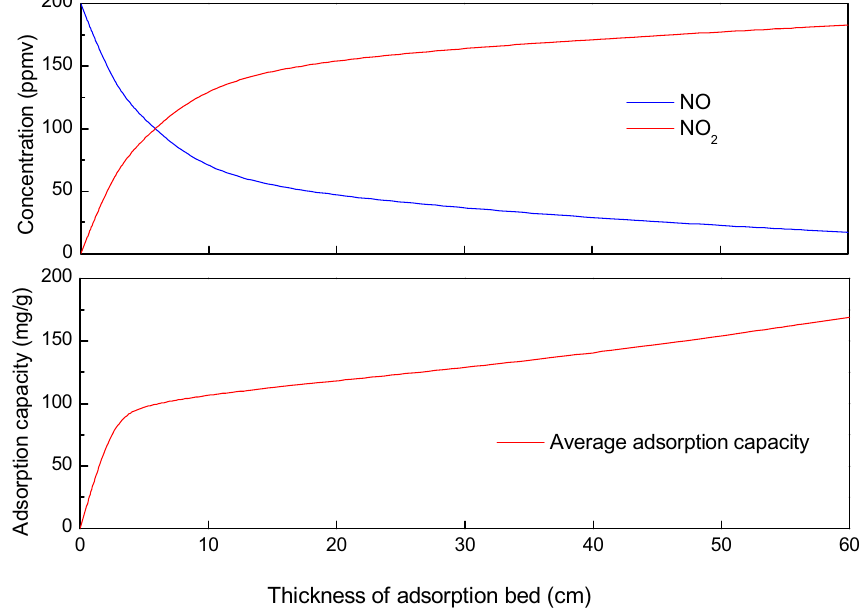
Figure 9. Oxidation and adsorption characteristics of NO–O 2 along activated carbon bed (NO = 200 ppmv, O 2 = 6 vol.%, T = − 20 ℃ , space velocity = 5000 h −1 when thickness is 60 cm).